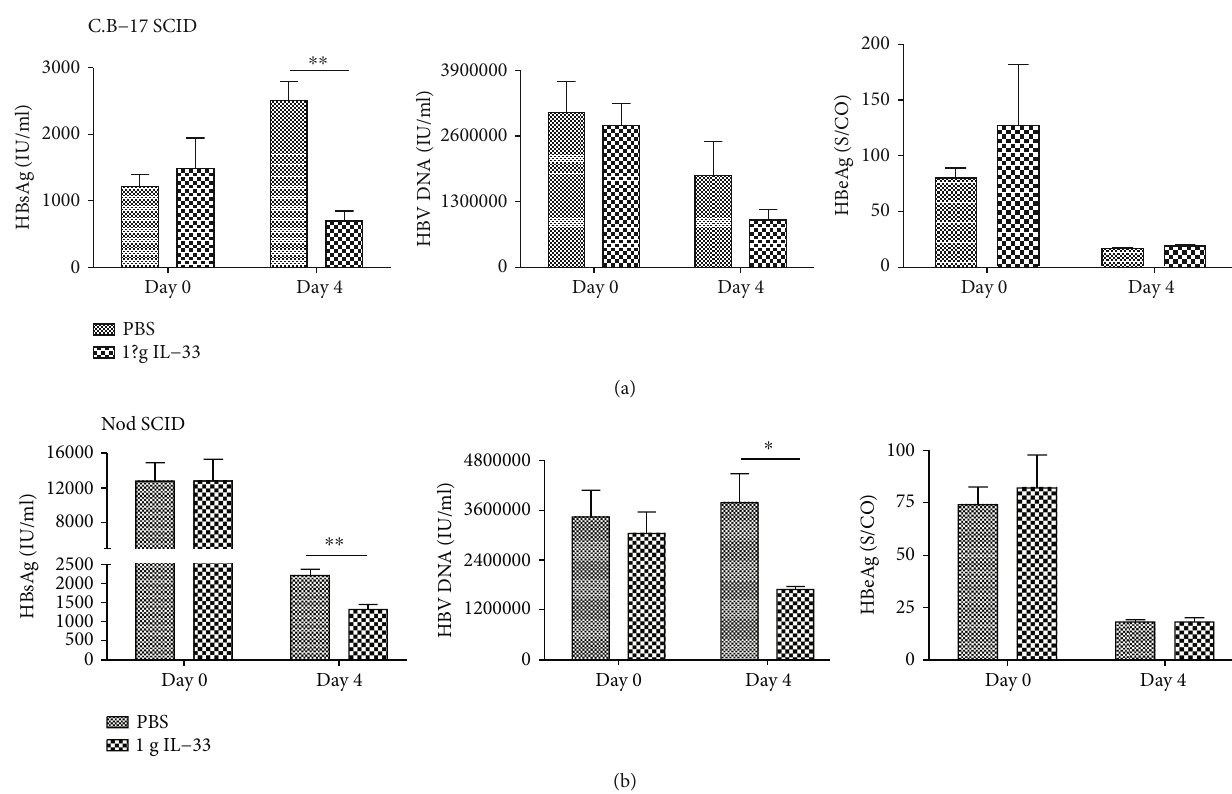
Figure 4: IL-33 can reduce the concentration of HBsAg, but has no signi fi cant e ff ect on HBV DNA in C.B-17 SCID HBV mice (a). IL-33 can reduce the concentration of HBsAg and HBV DNA in nod SCID HBV mice after IL-33 treatment (b). IL-33 has no e ff ect on HBeAg in both C.B-17 SCID and nod SCID HBV mice. The statistical signi fi cance of the data was determined using the Mann – Whitney test; P value is shown in each